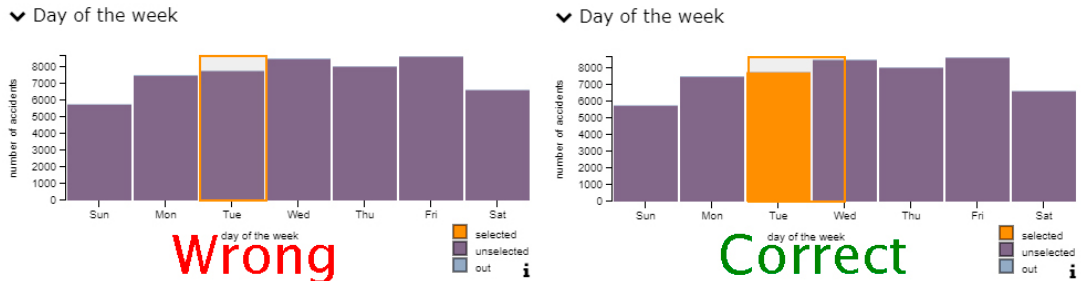
Figure 12. Problem with the selection of the bar in the Flanders Map. On the left side, the cursor is dragged over the bar, but the bar is not selected. On the right side, the correct way of selecting data is shown.